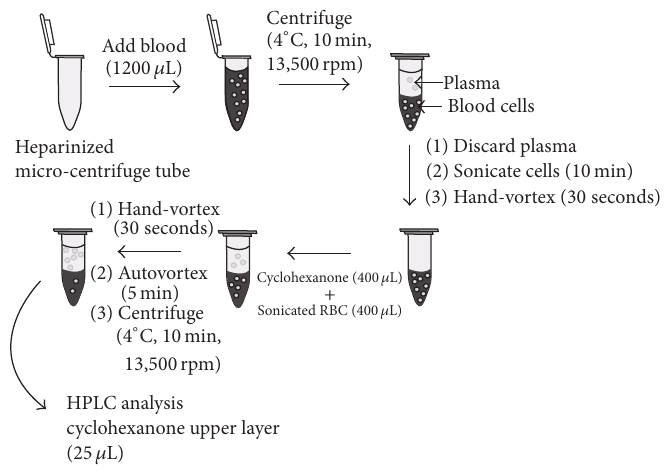
Scheme 1: Liquid-Liquid extraction method for determining DMTS in blood.